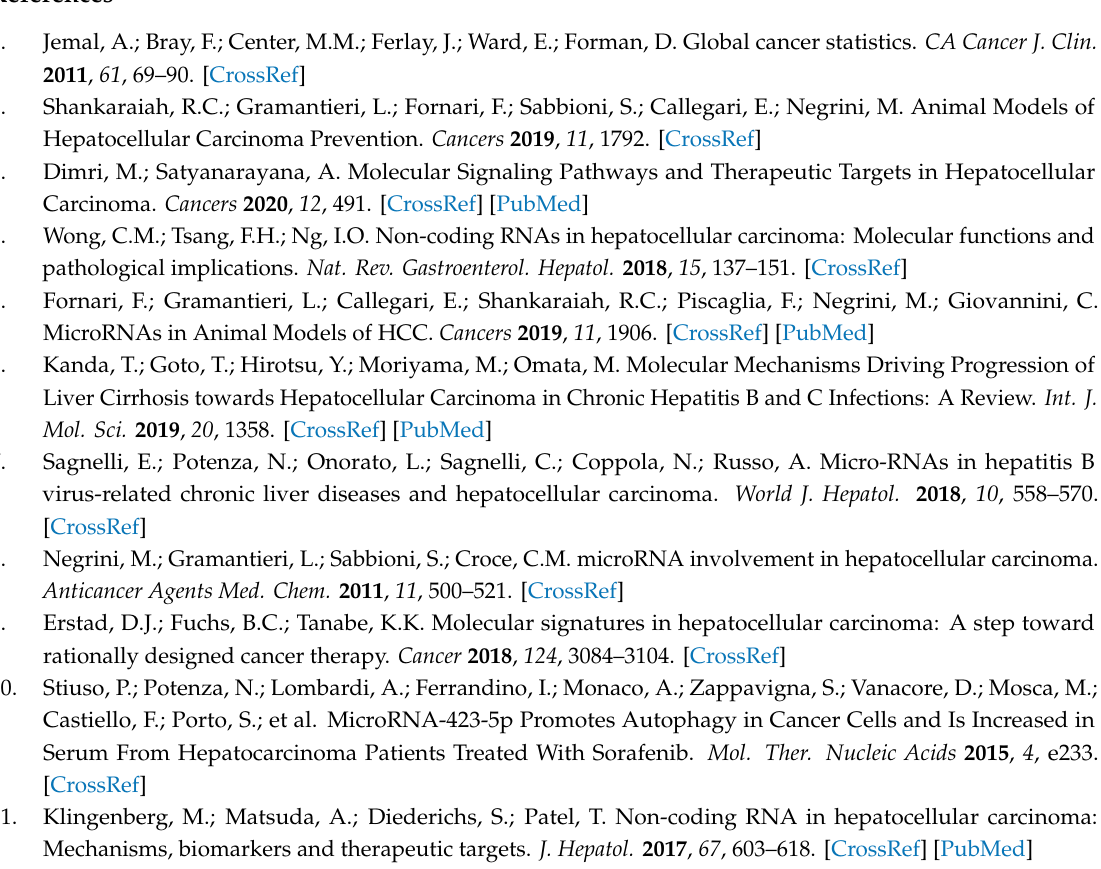
Table S1: Pearson correlation coe ffi cients (r) between indicated molecules in HCC tissues (data from Encori,